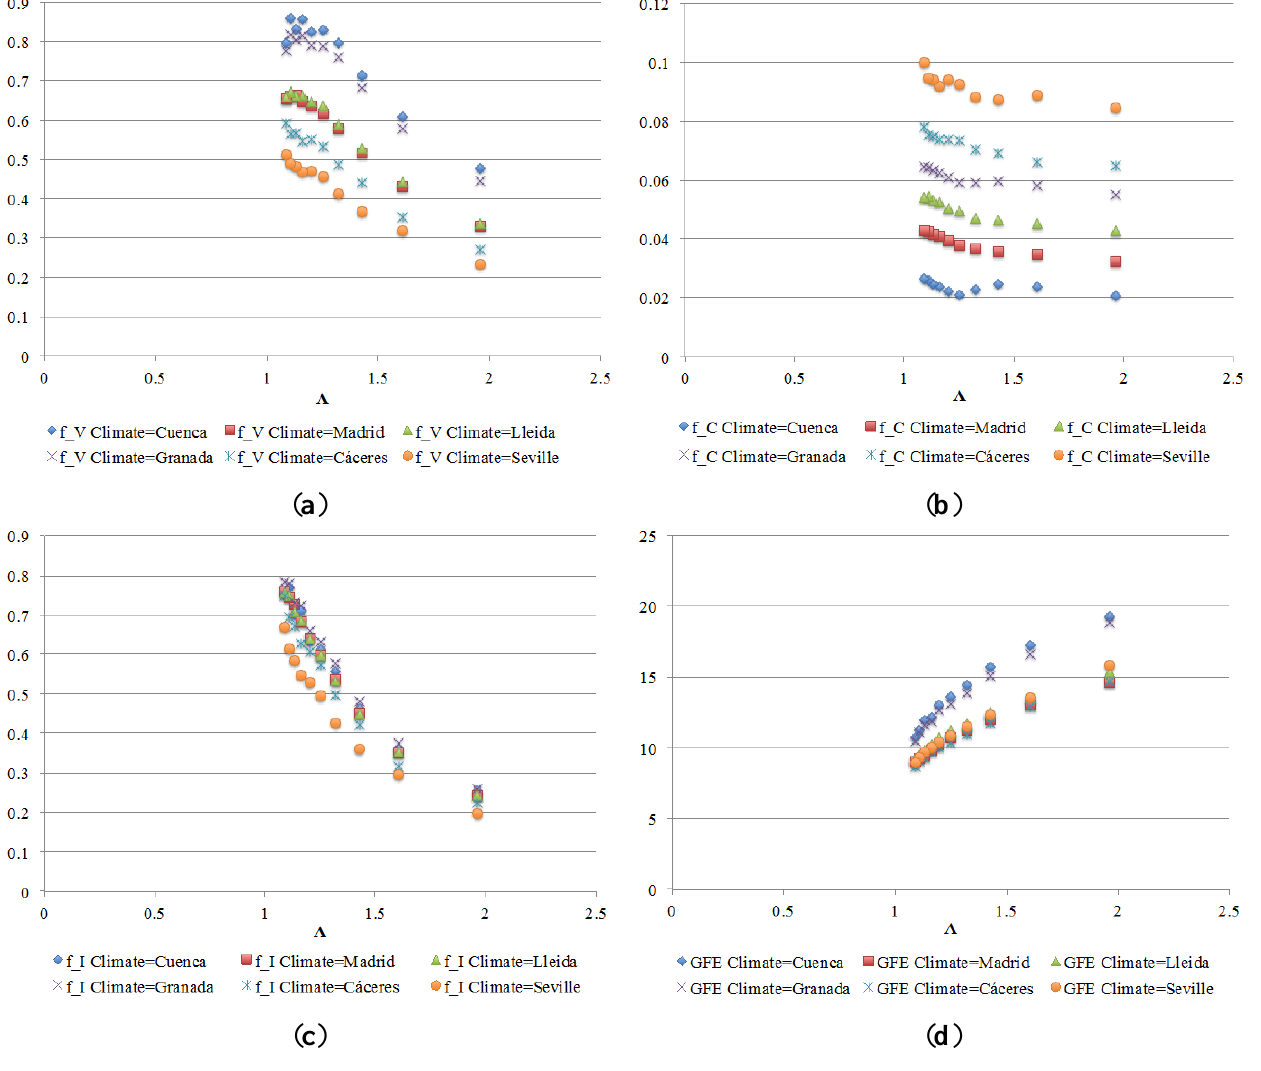
Figure 8. Indicators in different climates: ( a ) f V ; ( b ) f C ; ( c ) f I ; ( d ) GFE